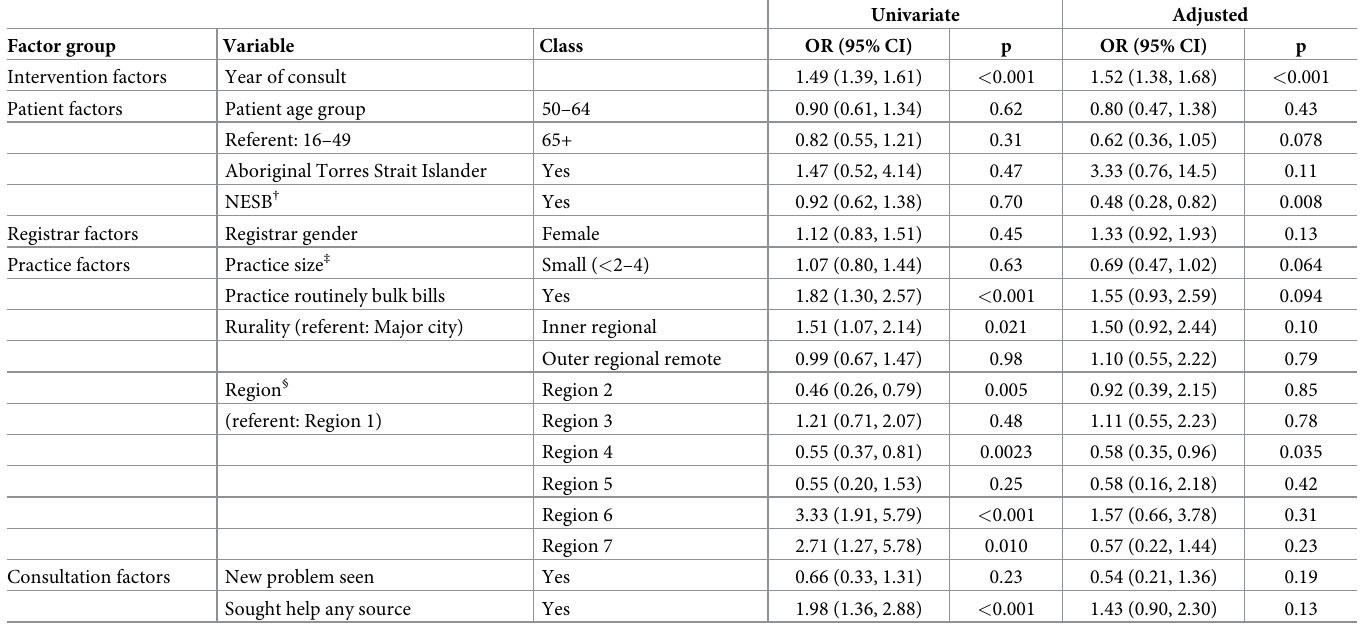
Table 3. Multivariable associations of GP registrar prescription of ‘new’ diabetes medications compared to sulphonylureas over time (2010–2018).